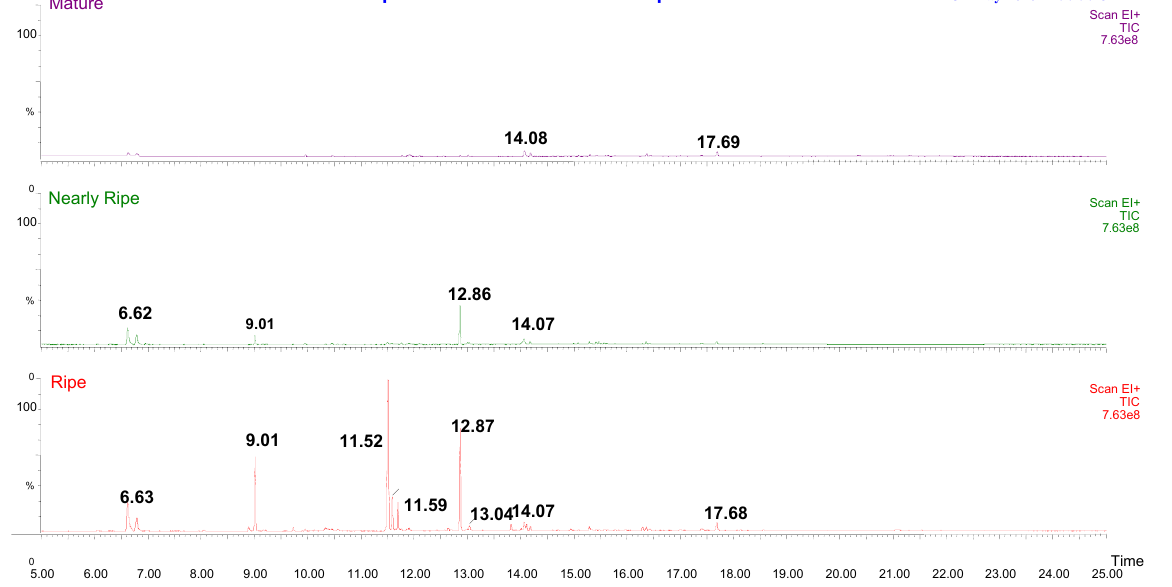
Table 6. Volatile compounds emitted from ripe, nearly ripe and ripe Harumanis mangoes.